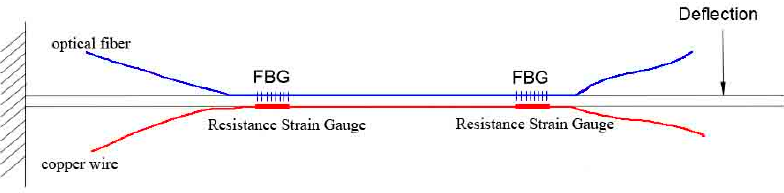
Figure 6. Sensor calibration setup.